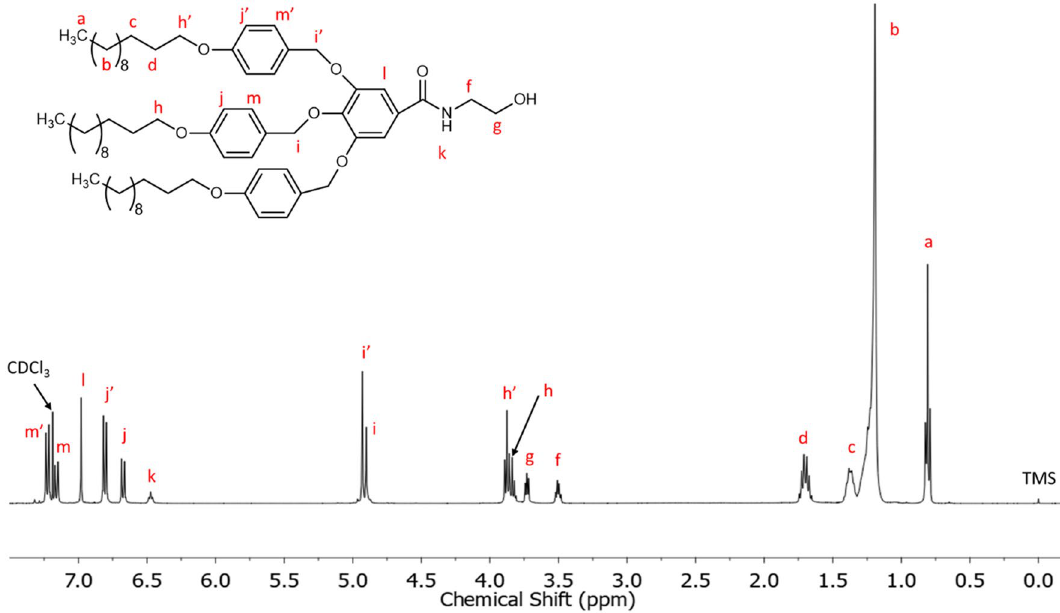
Figure 3. 1 H NMR spectrum in CDCl 3 of TAPAm.